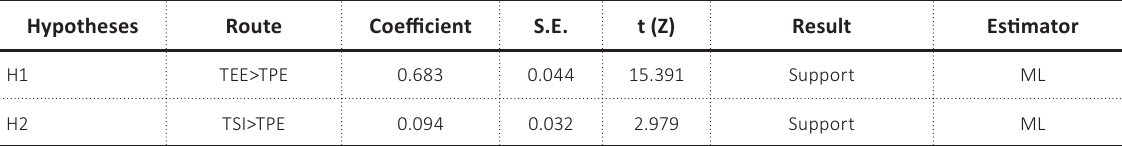
Table 8. Overview of statistical evaluation of research hypotheses